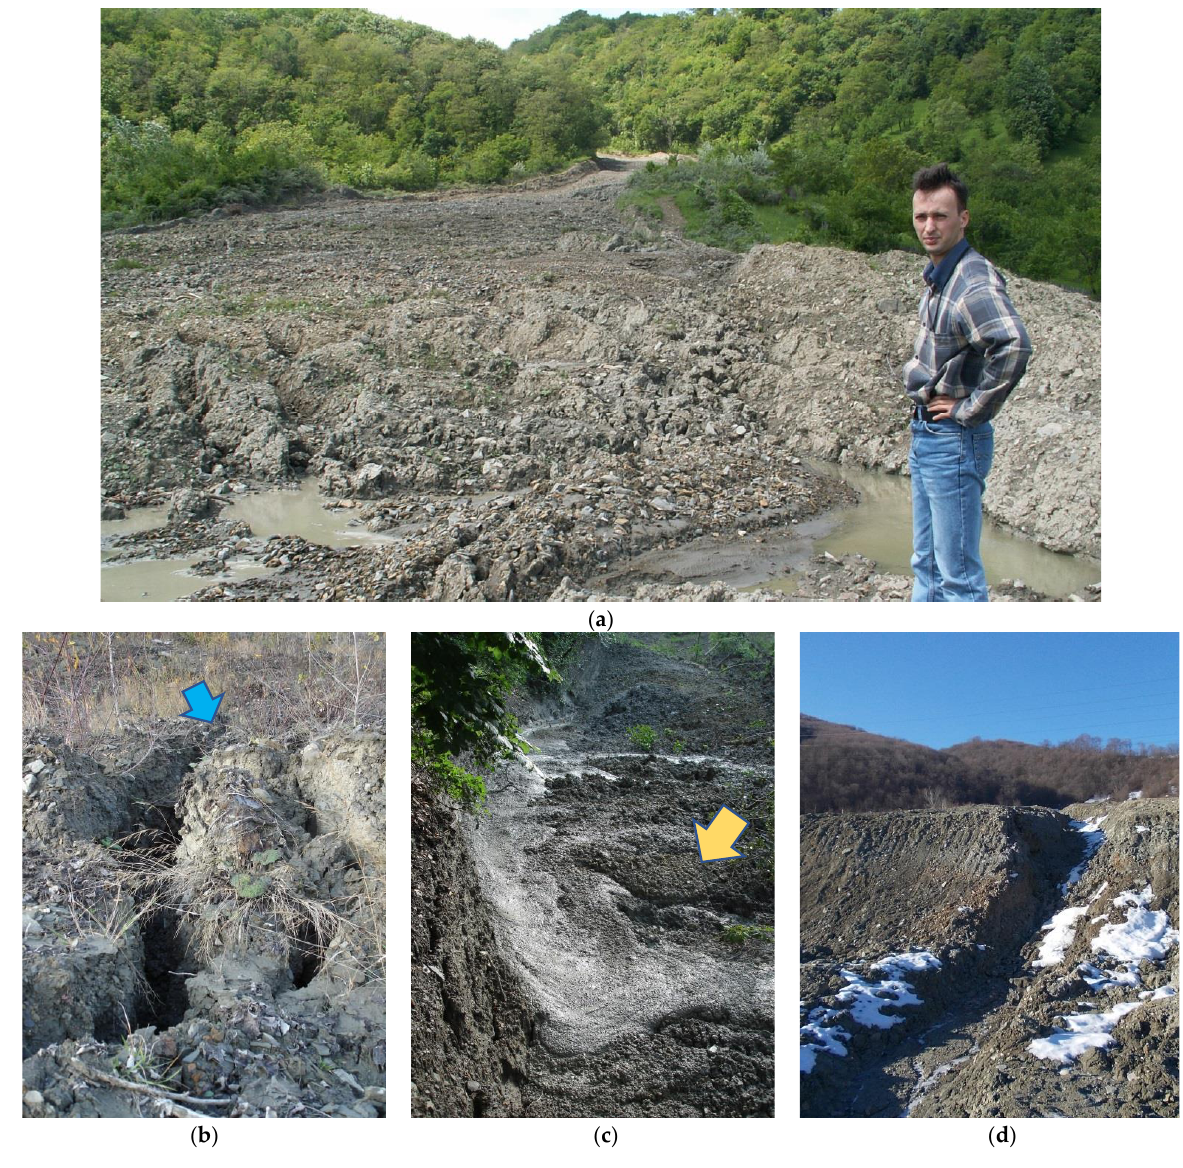
Figure 18. The Chirlesti mudflow site in Romania: ( a ) Daniel C. Diaconu standing on mudflow debris that was deposited on a nearly flat surface, and the road below was threatened near Chirlesti; ( b ) ruptures (blue arrow) along right and left flanks of the affected area; ( c ) a mudflow phenomenon (yellow arrow) is still in progress; and ( d ) a recent photo of the study area showing the height of mudflow debris from Chirlesti Village Road (photos by Daniel C. Diaconu).